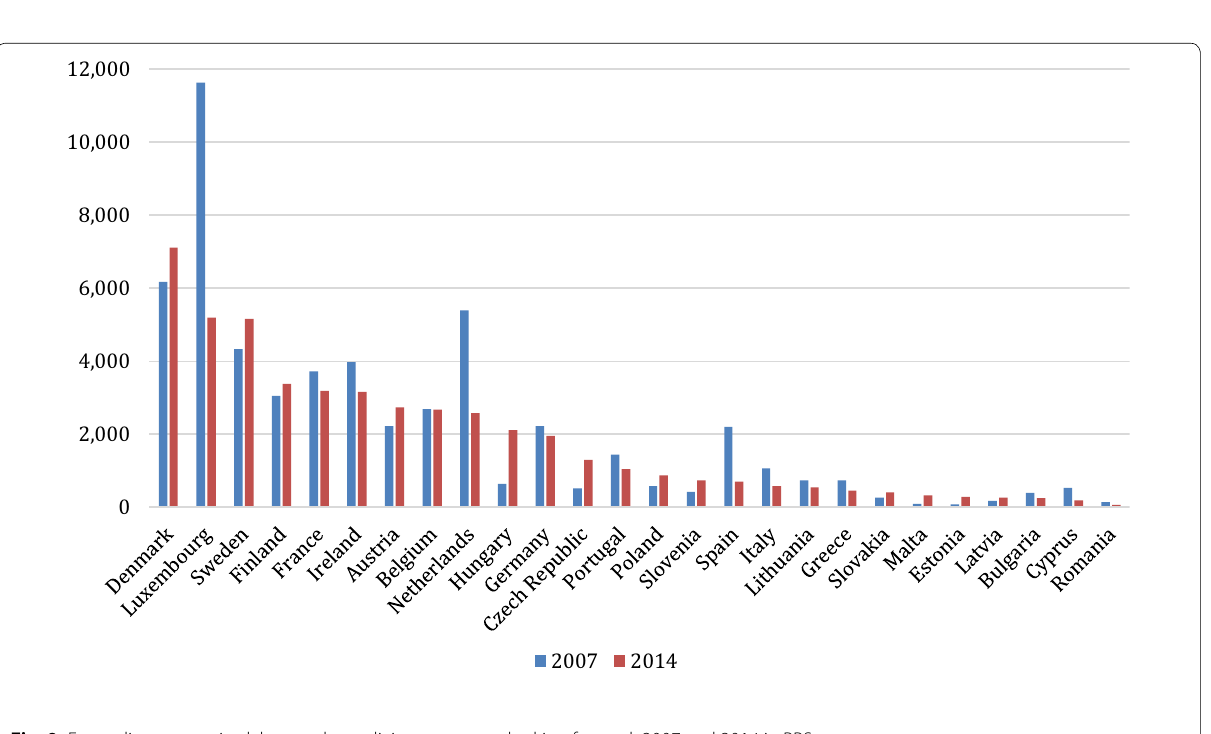
Fig. 9 Expenditure on active labor market policies per person looking for work 2007 and 2014 in